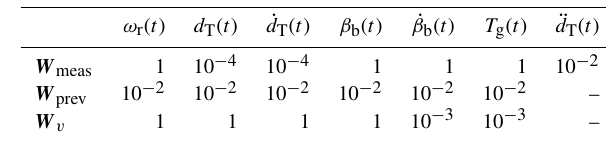
Table 2. Diagonal elements of the weighting matrices W penalizing the corresponding entries of the estimation y est and noise v